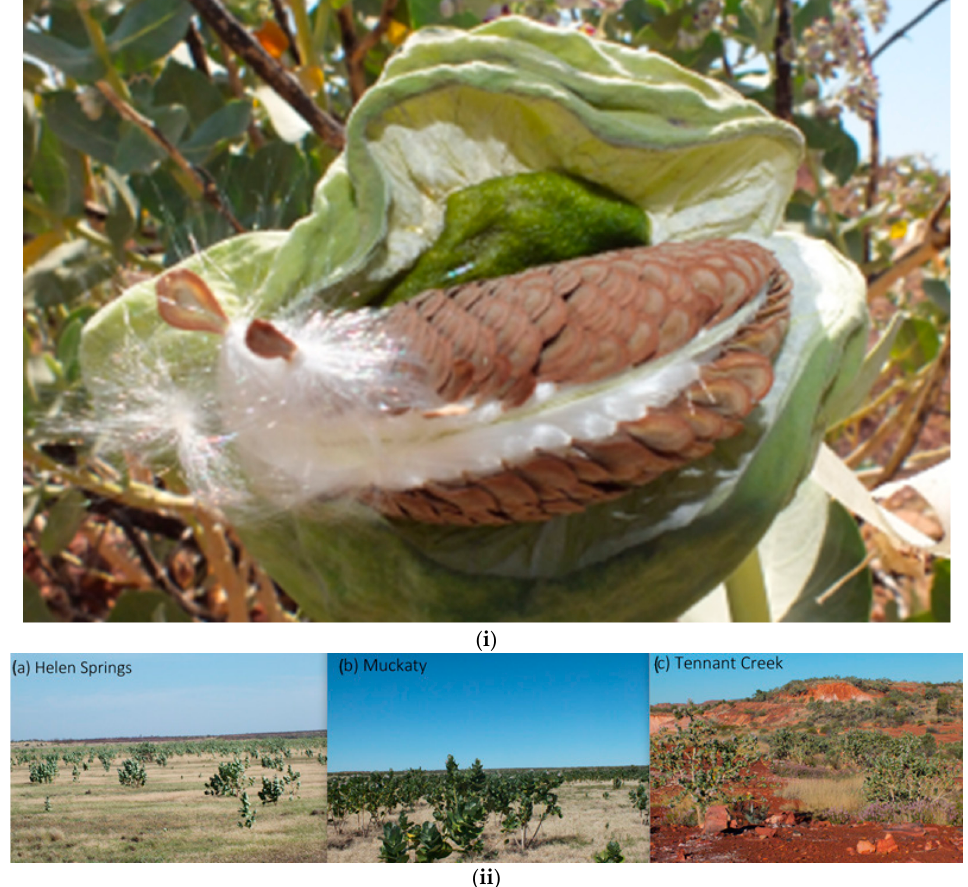
Figure 1. ( i ) Naturally dehisced rubber bush fruit with seeds starting to abscise. Note the delicate pappus. ( ii ) Physical appearances of the three study sites and their infestations.